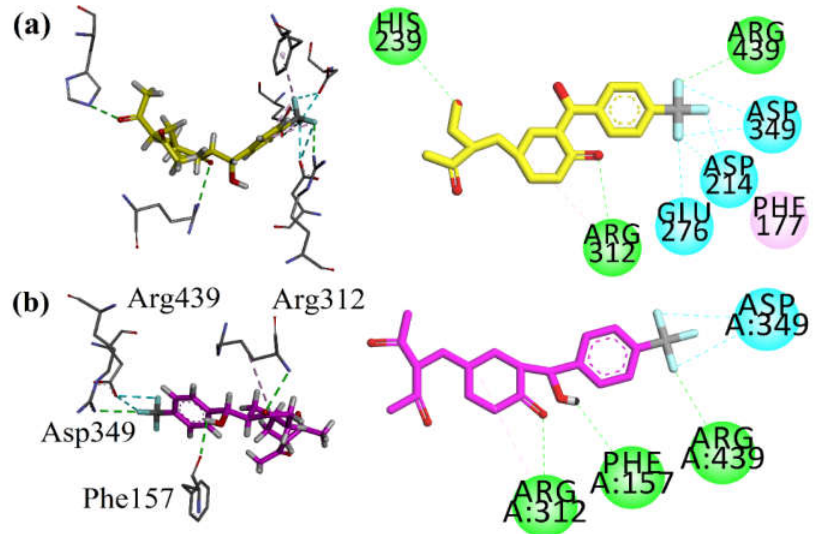
Figure 2. 3-D/2-D interaction plot of ( a ) major ( S , S , R - 5 , as yellow stick model) and; ( b ) minor ( S , S , R - 5 , as pink stick model) diastereoisomers into the binding site of homology modeled α-glucosidase.